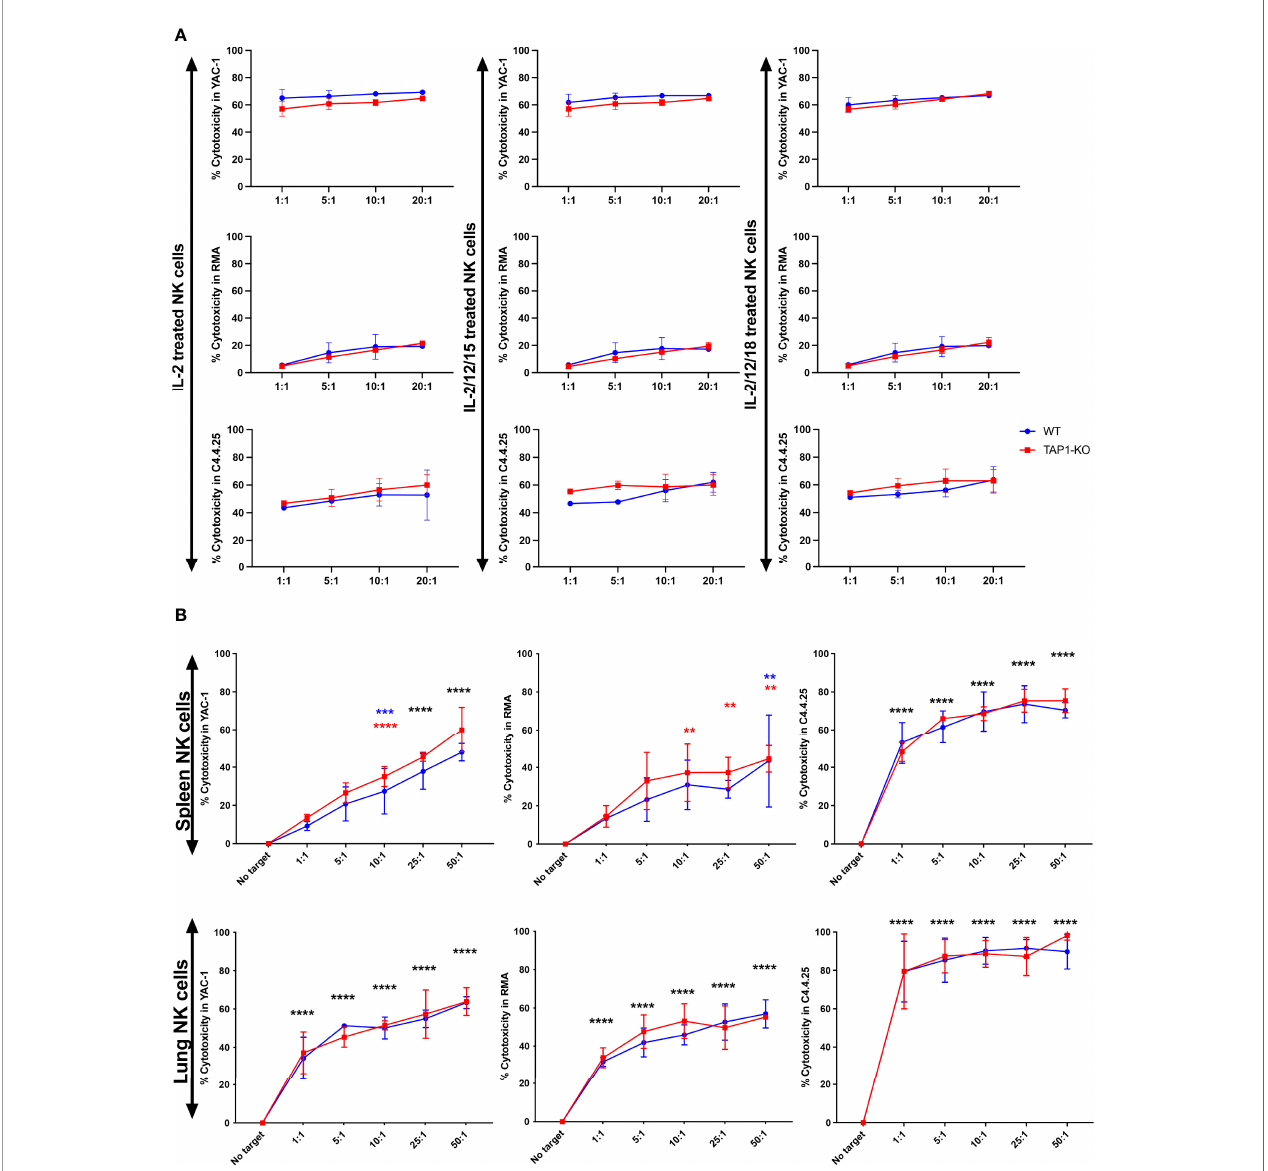
FIGURE 10 | (A) NK cells derived from murine spleen were expanded overnight in IL-2 and stimulated with IL-2 alone, (IL-2, IL-12, IL-15) or (IL-2, IL-12, IL-18) cytokines overnight. These cells were then co-cultured with the targets YAC-1, RMA and C4.4-25- for four hours. The cytotoxicity was measured with TO-PRO-3 staining. (B) NK cells derived from murine spleen and lung were expanded in the presence of IL-2 for 5 days and then restimulated with IL-2 alone overnight. These cells were then co-cultured with the targets YAC-1, RMA and C4.4-25- for four hours. The cytotoxicity was measured with TO-PRO-3 staining. **, p<0.01, ***, p<0.001, ****,